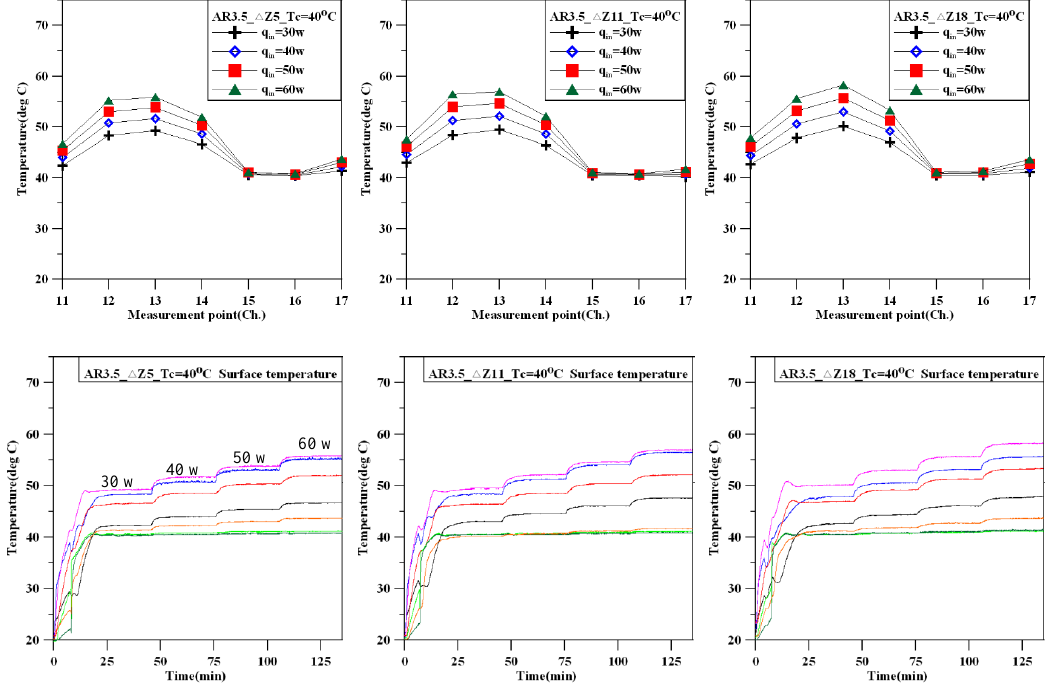
Figure 4. Exterior wall temperature variation along the loop as a function of the heating power.